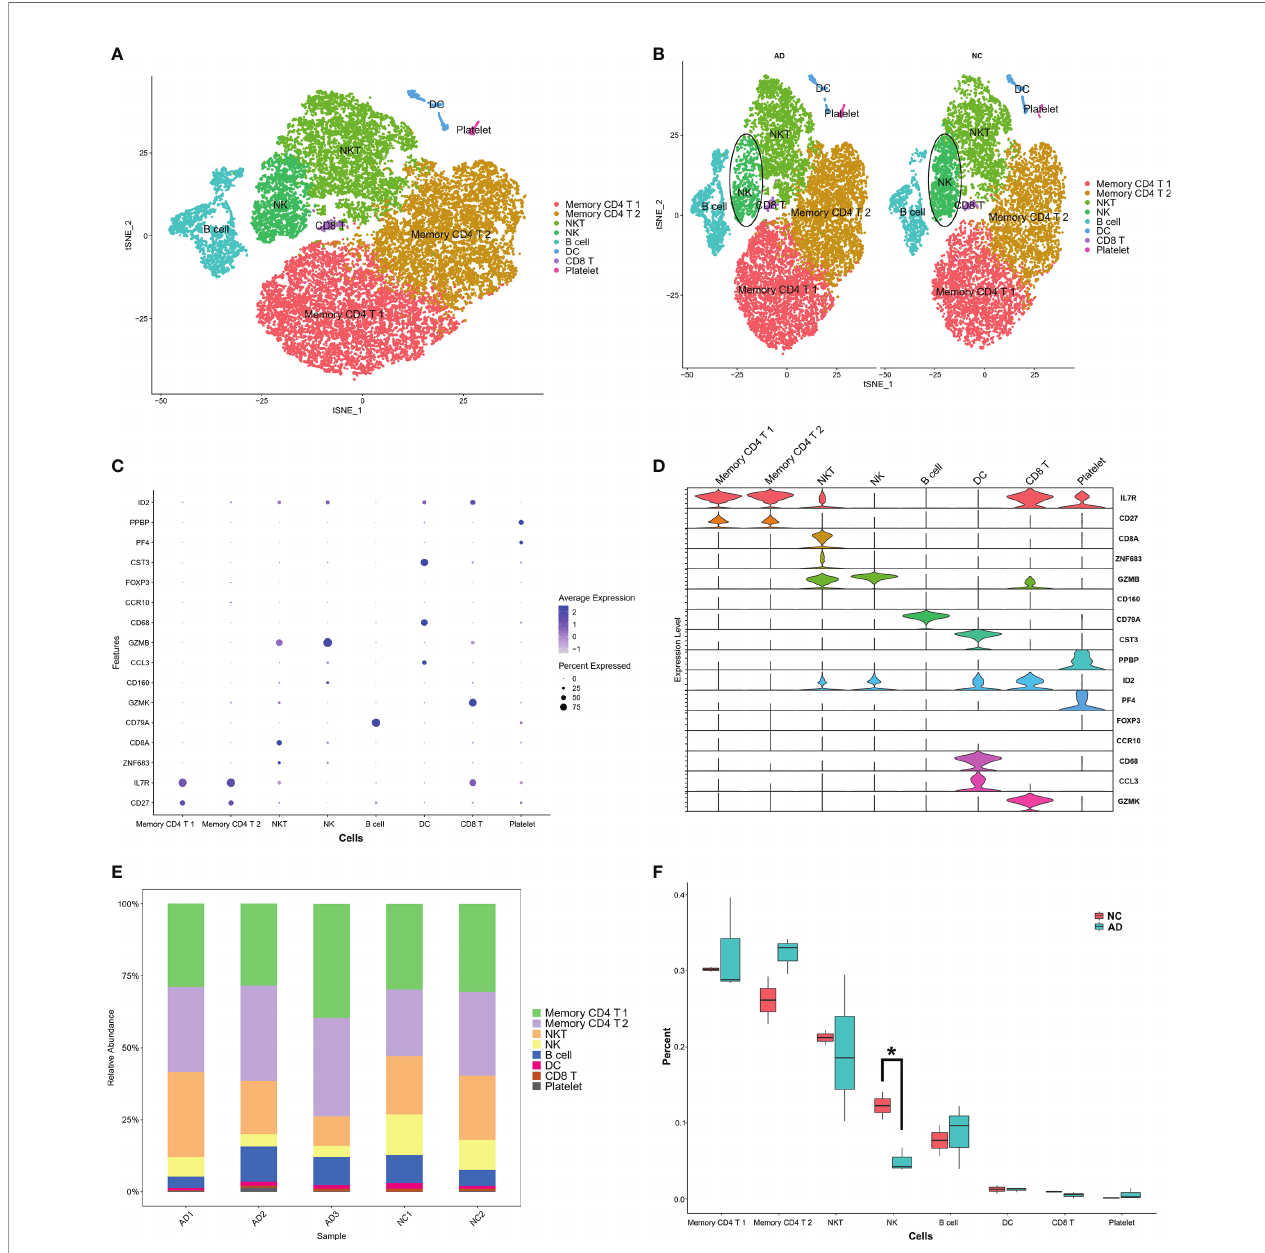
FIGURE 2 | Marker gene expression of each cluster. (A) tSNE projection of 24,679 cells from all PBMCs. Different cell types were colored with unique colors. (B) tSNE projection of AD and NC groups, respectively. NK cells were labeled with ellipse tag, which were decreased in AD group. (C) Dot plot of cell type marker genes. Cell speci fi c marker genes were selected according to previous study by Sinha D (11). The color of dots represents average expression, and size of dots represents average percent of cells expressing selected gene. (D) Violin plot depicts distributions of cell type marker genes in each cluster using density curves. The width of each violin plot corresponds with the frequency of cells with relevant gene expression level. (E) Cluster distribution in each sample. (F) Cluster distribution in AD and NC group. The percent of NK cluster was decreased in PBMC of AD group. * means, P < 0.05 compared with NC